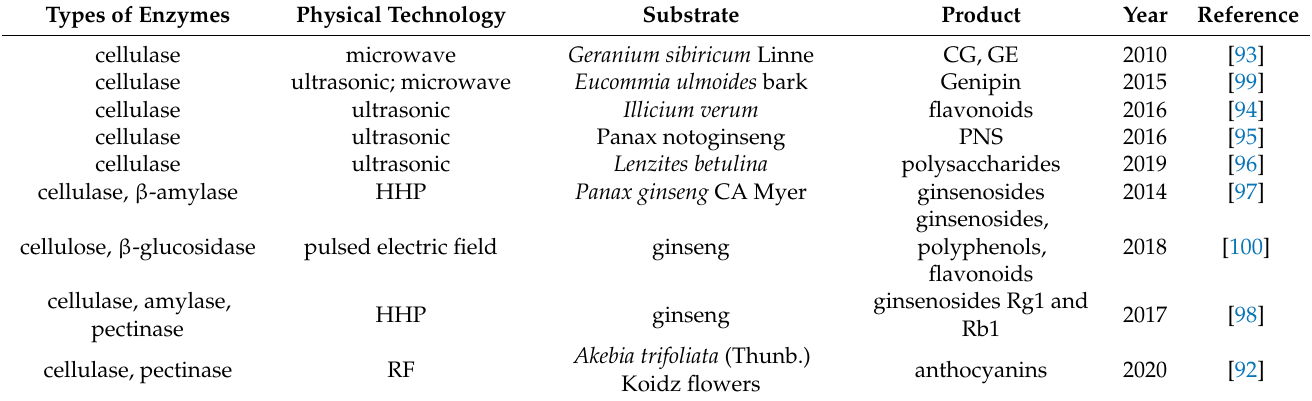
Combined application of cellulase or mixed enzymes and physical techniques in the extraction of bioactive